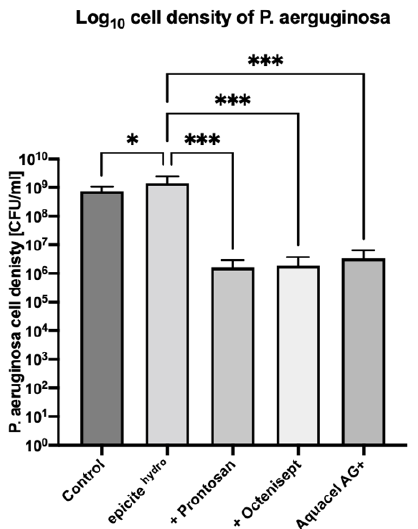
Figure 2. Log 10 cell density of P. aeruginosa (ATCC 700888) 24-hour biofilm following 48-hour treatment with the test dressings. All dressings were tested in triplicate. Error bars represent standard deviation of the mean. Asterisks represent the significant difference between the samples and the untreated control or epicite hydro® exclusively.